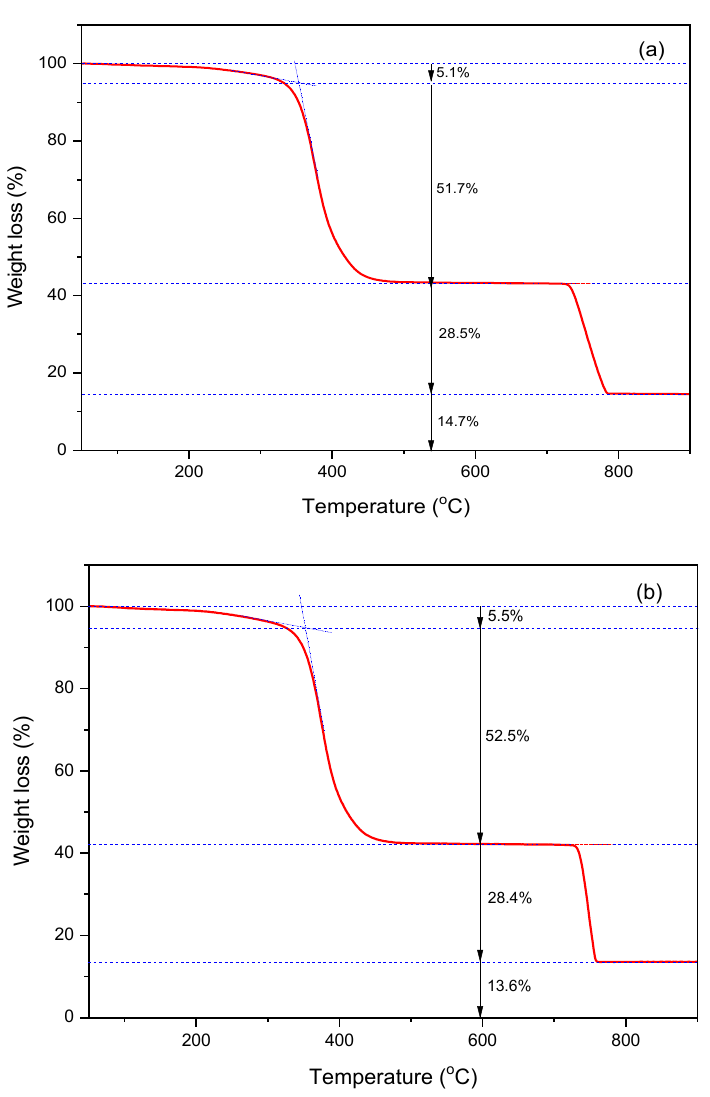
Figure 4. TGA thermograms of the model TRWPs made of the chloroform-treated TWP by the single ( a ) and double ( b ) step pressing procedures. Shapes and surfaces of the TRWPs made of the untreated TWPs and the asphalt pavement wear particles looked like the TRWPs made of the MPs, and some large-sized particles were observed on the surface (Figure S11; Supplementary Information). However, the TRWPs made of the chloroform-treated TWPs and the asphalt pavement wear particles had different surfaces, and there were some plate-type particles which were marked by the yellow circle and arrow in Figure 5. The plate-type particles are also observed in real TRPWs. Hence, plate-type particles in real TRWPs might be asphalt pavement wear